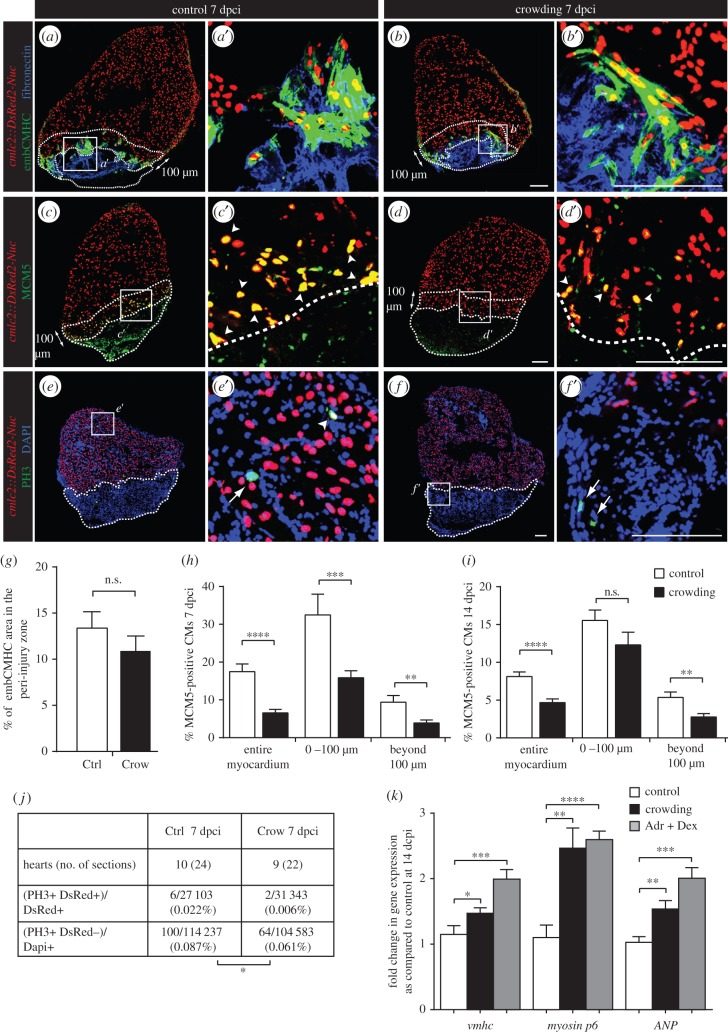
Daily acute stress exposure after cryoinjury affects CM proliferation and triggers compensatory mechanisms associated with cardiac overload. (a–f) Immunofluorescence staining of heart sections at 7 dpci of cmlc2::DsRed2-Nuc (cardiac nuclei, red) transgenic zebrafish of control and stressed animals. Dashed lines encircle the cryoinjured parts and a 100 µm-wide margin of the remaining myocardium along the injury border (peri-injury zone). (a–b′) No change in expression of embCMHC (embryonic isoform of cardiac myosin heavy chain, MAb N2.261, green) and fibronectin (blue) is observed between both experimental groups, N ≥ 4. (c–d′) The G1/S phase marker MCM5 (green) is reduced in CM nuclei of the stressed animals, particularly in the peri-injury zone. Arrowheads indicate double positive cells. (e–f′) The mitosis marker PH3 (green) is less frequent in the stressed animals as compared to controls. Arrows indicate mitotic non-CMs. (g–j) Quantification of immunofluorescence analysis shown in the representative images. N ≥ 8 hearts; three sections per heart. (k) qRT-PCR experiments revealed that exposure to crowding or dexamethasone/adrenaline (Adr + Dex) for 1 h d−1 during 14 days after cryoinjury results in upregulation of genes associated with cardiac compensatory response; N ≥ 2 sets, 10 hearts each. *p < 0.05, **p < 0.01, ***p < 0.001, ****p < 0.0001. Scale bars, 100 µm.